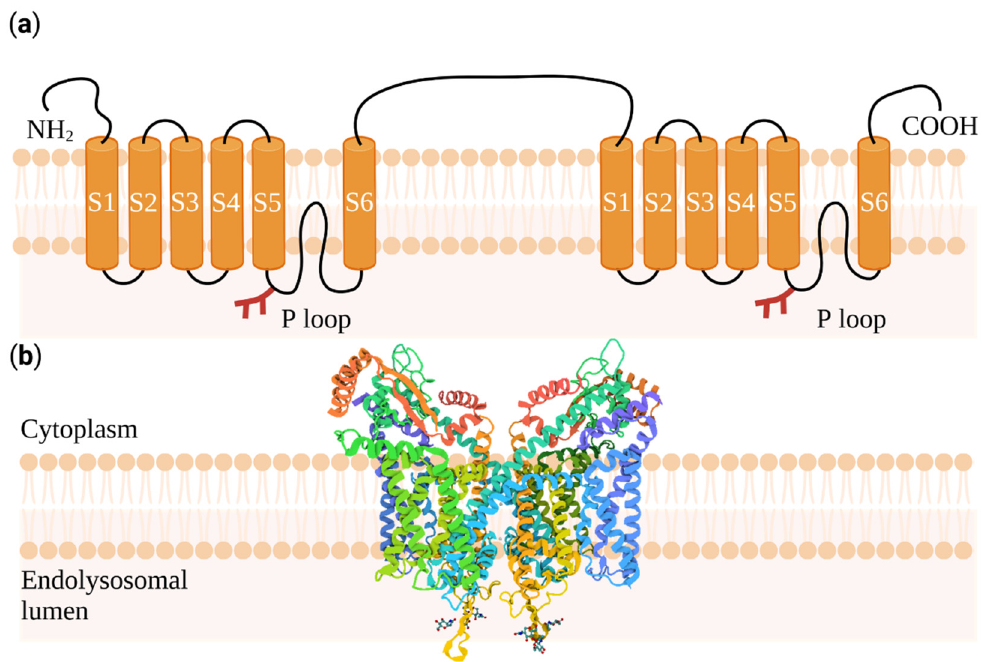
Figure 1. Structure of TPC1 in biological membranes. ( a ) The scheme illustrates TPC1 as a homodi- mer where each subunit is composed of six transmembrane domain helices. The luminal red appendages show the glycosylation sites on each P-loop. Each subunit forms a pore region between the 5th and 6th segment (S); ( b ) the cryo-EM structure shows TPC1 of Mus musculus at a resolution of 3.5 Å in the apo state. For the illustration, the protein data bank (PDB) code 6C96 was applied. Created with BioRender.com, accessed on 29 March 2022.